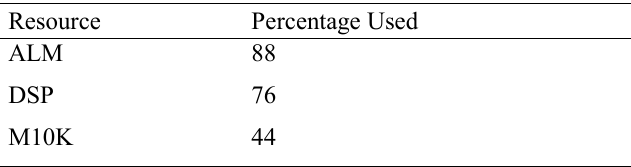
Figure 6. High Level Partial Compute Block